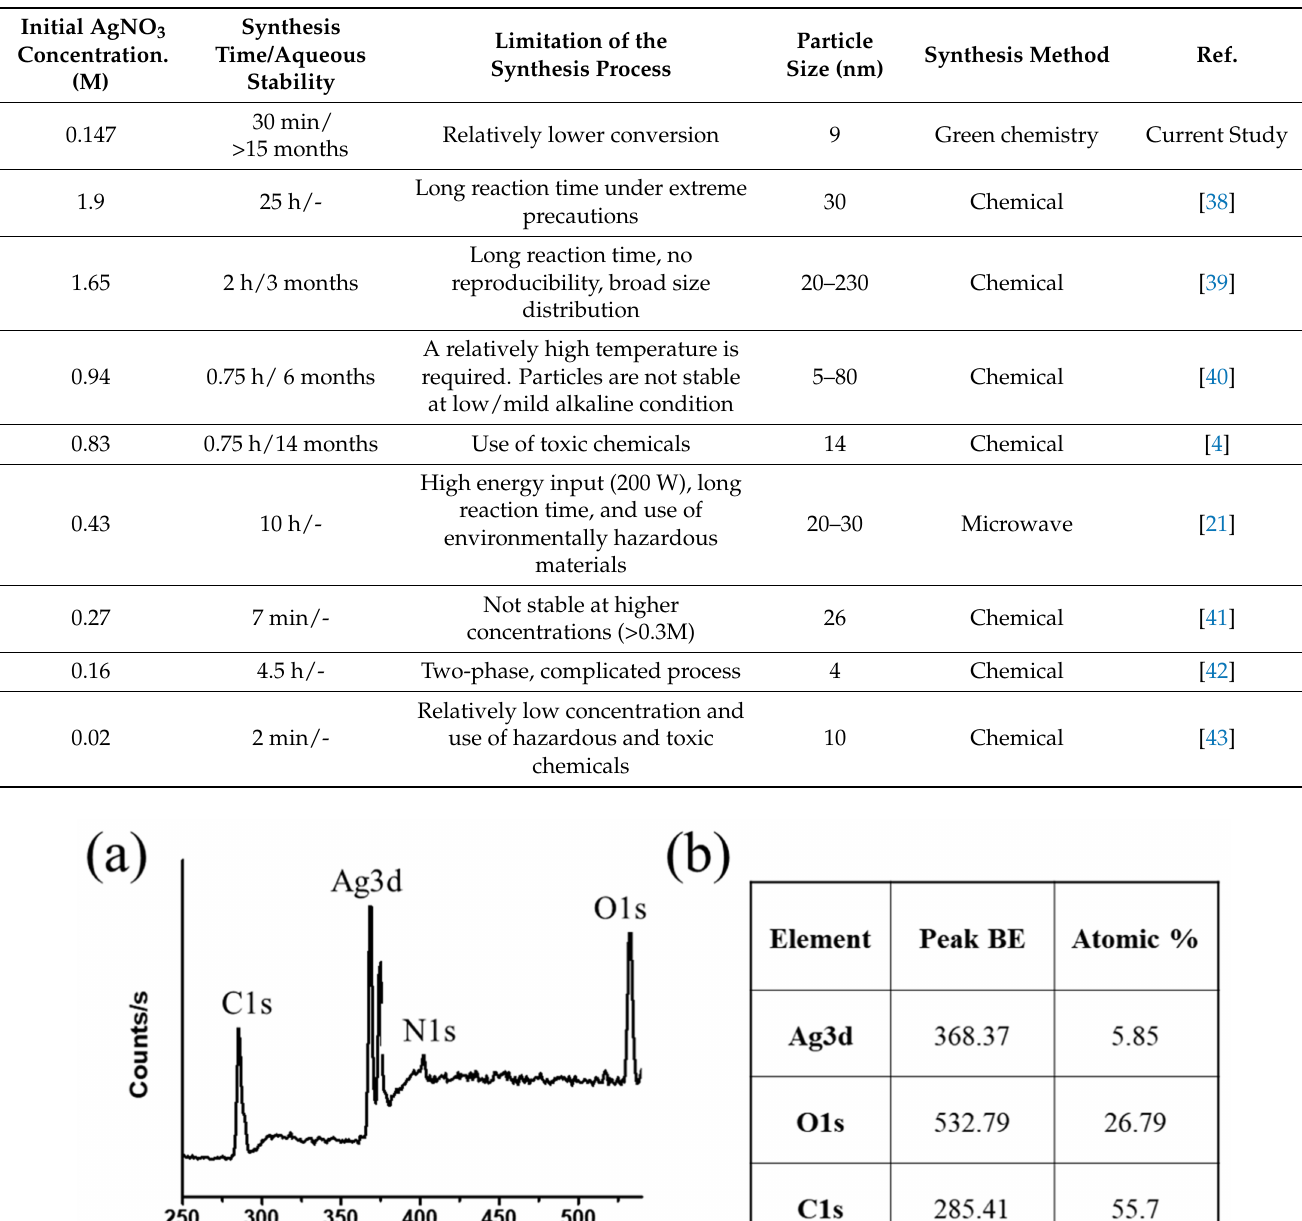
Table 1. Characteristics of synthesized Ag NPs synthesized in this study in comparison with those synthesized in previous studies. Initial AgNO 3 Concentration.